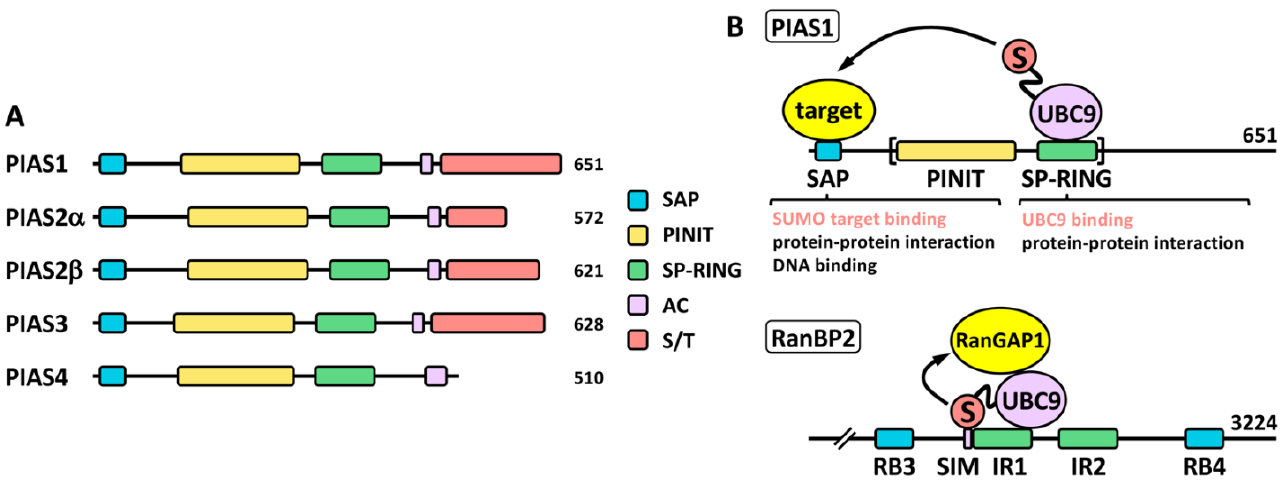
Figure 3. The PIAS family. ( A ) Schematic representation of human PIAS proteins. The SP-RING and SAP domains, together with the PINIT region, the acidic stretch (AC) and the C-terminal Ser/Thr (S/T) rich region, are shown. Two alternative isoforms, α and β , have been classically described for PIAS2. The number of amino acids is also shown for each protein. ( B ) Proposed ligase mechanisms using PIAS1 and RanBP2 as models. In the case of PIAS1, simultaneous binding of target and SUMO-loaded UBC9 through different domains may facilitate SUMO transfer to the target. The SP- RING is important for UBC9 binding but may also mediate other protein interactions for additional